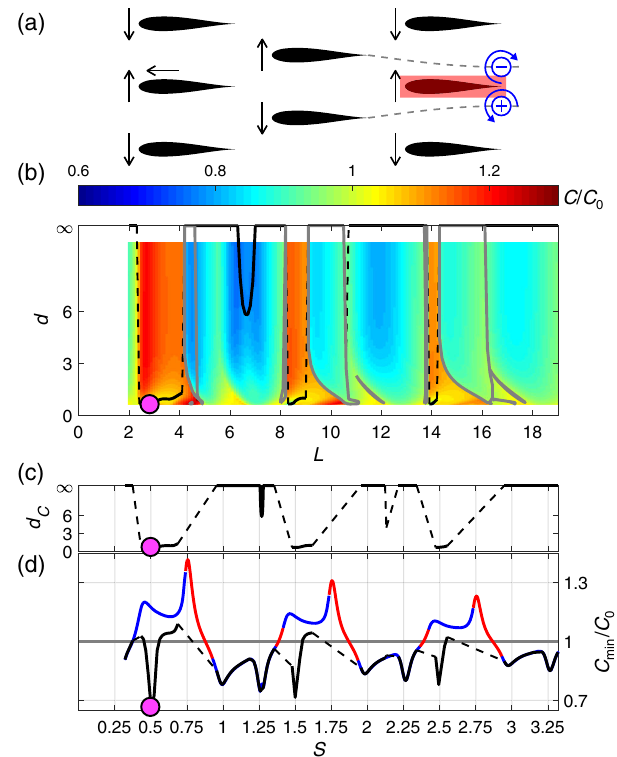
FIG. 8. Cost of transport in a diamond lattice. The procedure described in the caption of Fig. 6 is repeated for a diamond lattice. The state with the lowest cost of transport has C=C 0 ¼ 0 . 67 for L ¼ 2 . 8 and d ¼ d , corresponding to S ¼ 0 . 5 min